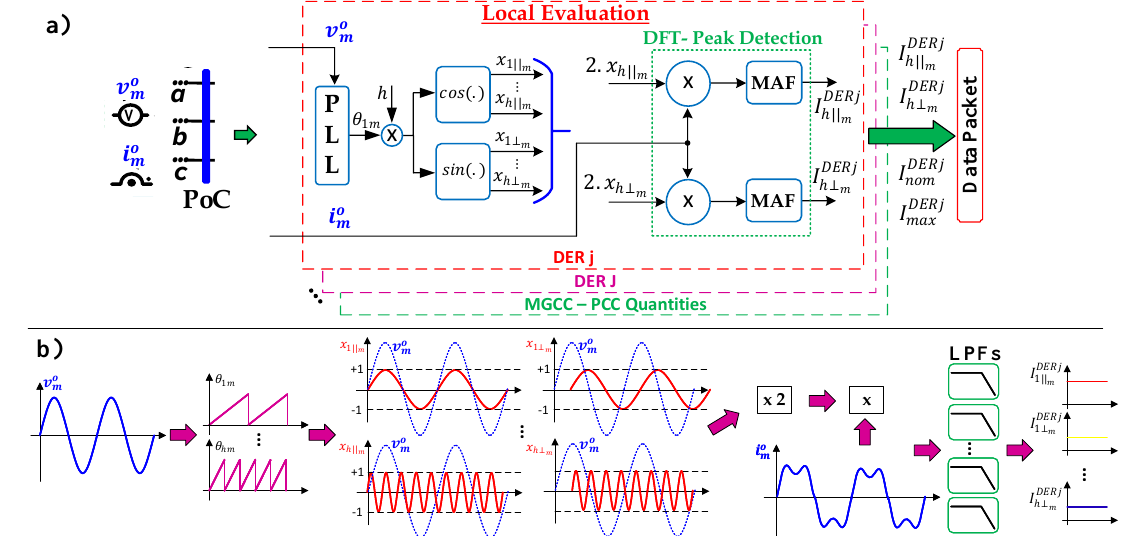
Figure 4. Task 1—Local evaluation of electrical quantities. ( a ) Decomposition scheme; and ( b ) illus- tration of the procedure in ( a